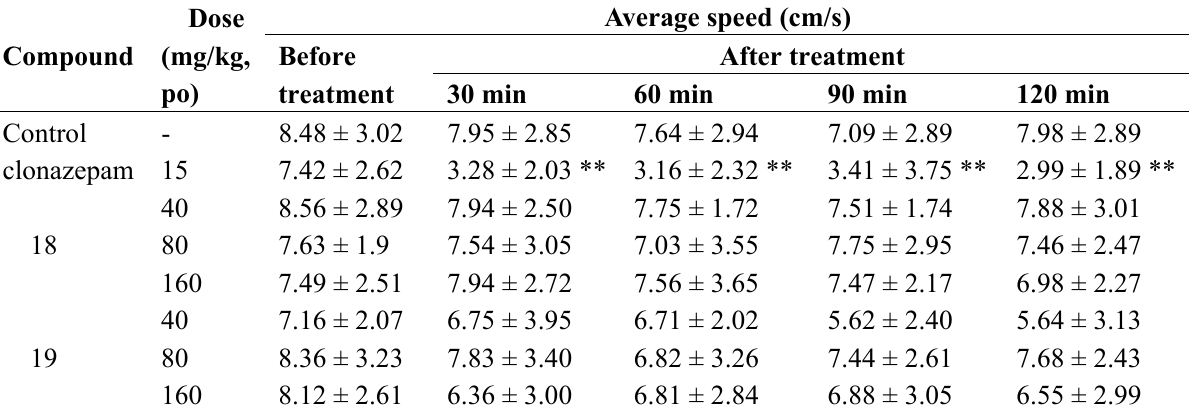
Table 3. Effects of compounds on exploratory locomotors